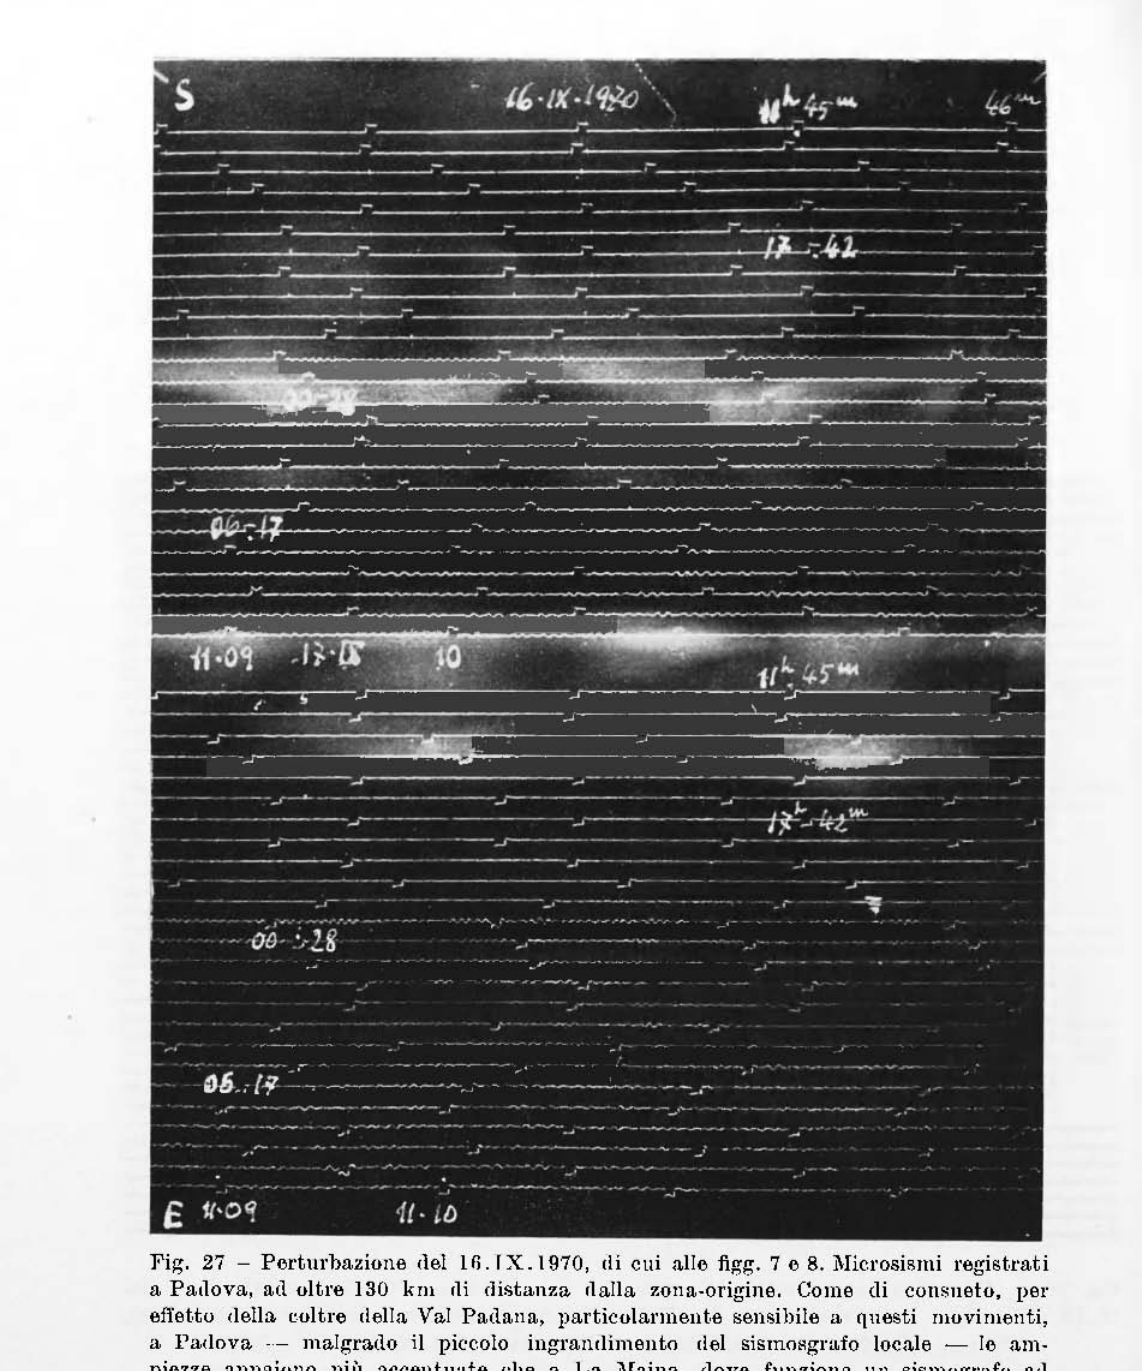
Fig. 27 - Perinrbatioll of Sept. IU, 1970, Wl per figur8S 7 and 8. )!icroseisms reeunled at Palluva at over 130 kms of dist.ance from the origin.area. As nsnally,